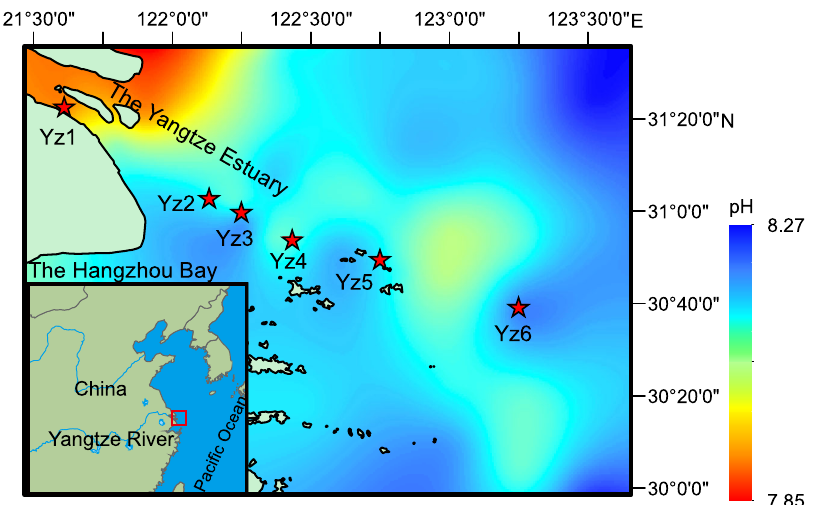
Fig. 1 | Study area and sampling locations overlaid on pH values of near-bottom water. Stations are marked by red